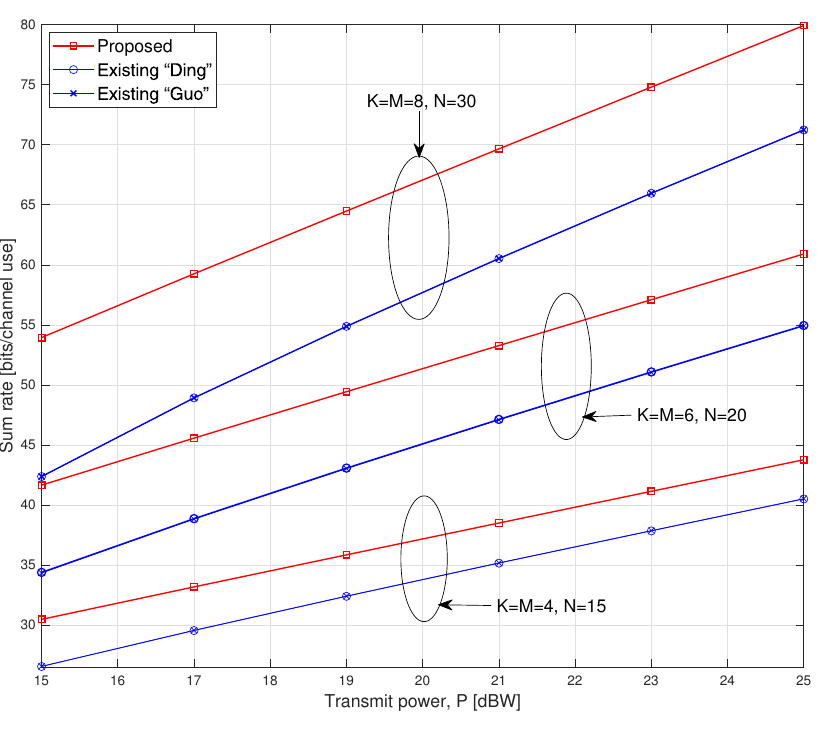
Figure 2. Sum rate versus the transmit power P when K = M ∈ { 4,6,8 } and N ∈ { 15,20,30 }